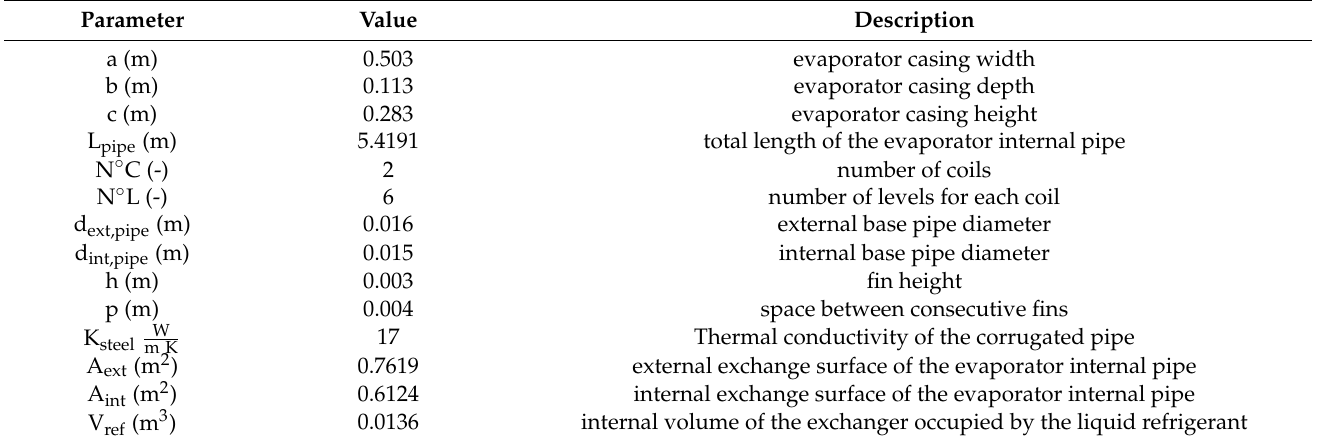
Figure 2. Schematic representation of the evaporator. Table 1. Evaporator geometrical data.